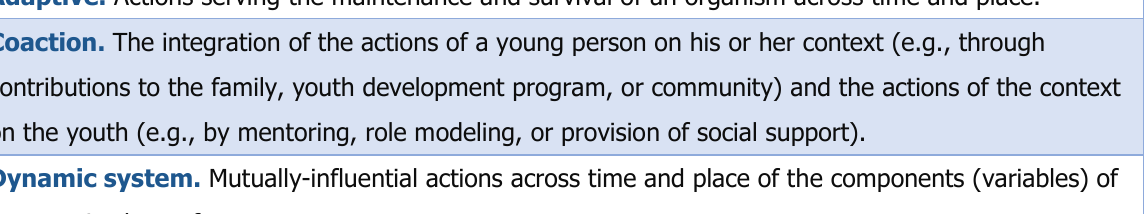
Table 1. Concepts Associated with Relational Developmental Systems Metatheory Activity. The biological, psychological, and social functions of a living organism across time and place. Adaptive. Actions serving the maintenance and survival of an organism across time and place. Coaction. The integration of the actions of a young person on his or her context (e.g., through contributions to the family, youth development program, or community) and the actions of the context on the youth (e.g., by mentoring, role modeling, or provision of social support). Dynamic system. Mutually-influential actions across time and place of the components (variables) of an organized set of